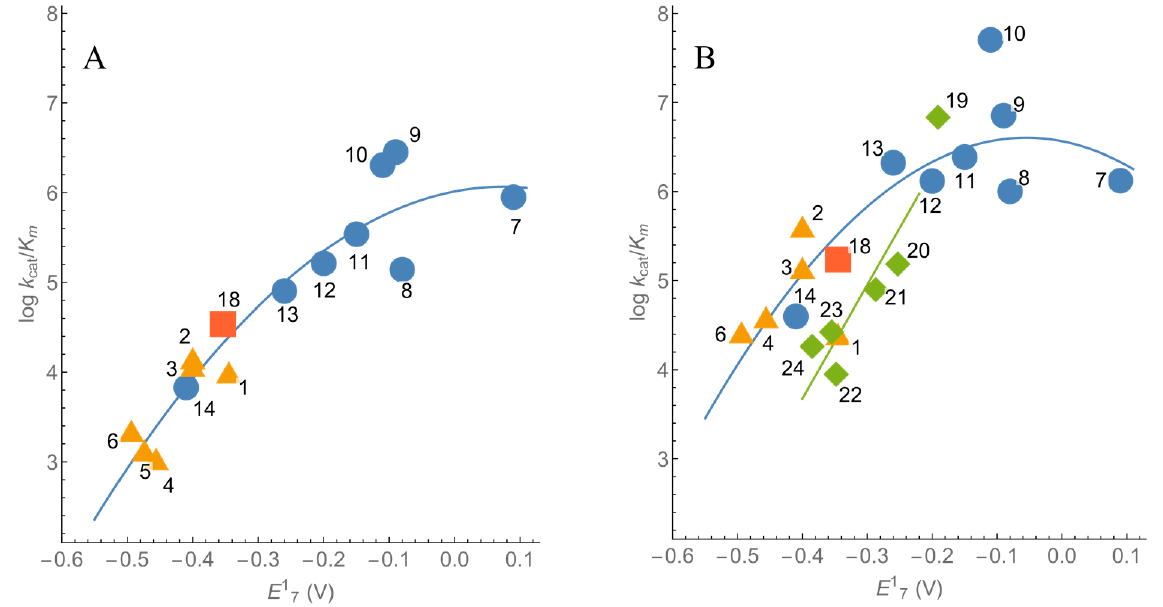
Figure 1. The dependence of the reactivity of quinones (blue disks), aromatic N -oxides (orange triangles), nitroaromatic compounds (green diamonds) and benzylviologen (red rectangle) on their single-electron reduction midpoint potentials ( E 1 7 ) at pH 7.0 in the absence ( A ) and presence ( B ) of CAM and Ca 2+ . The numbers of compounds are given in Table 1.